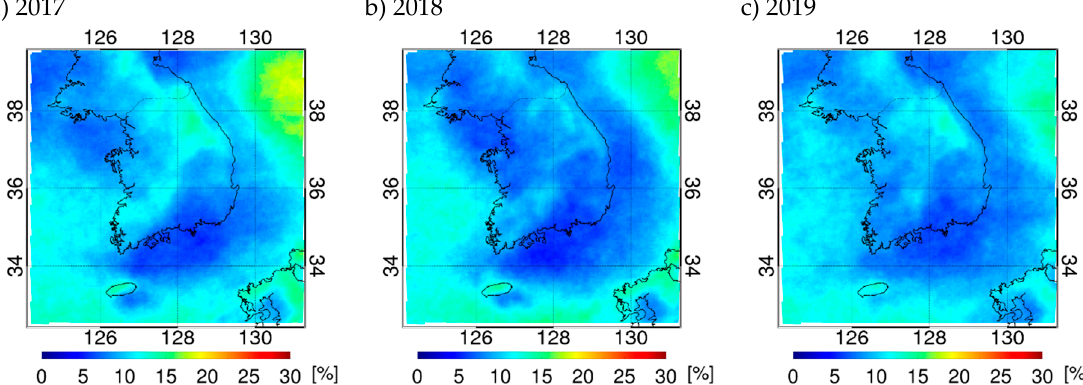
Figure 6. Annual frequency distribution of seedable clouds ( a – c ) around the Korean Peninsula.